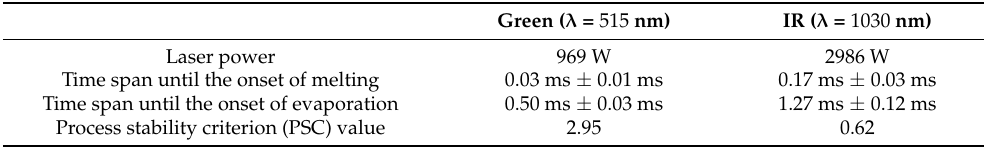
Table 1. Heat-up time spans until melting and evaporation is reached for copper. The laser powers were chosen such that the spot welds featured equal mean welding